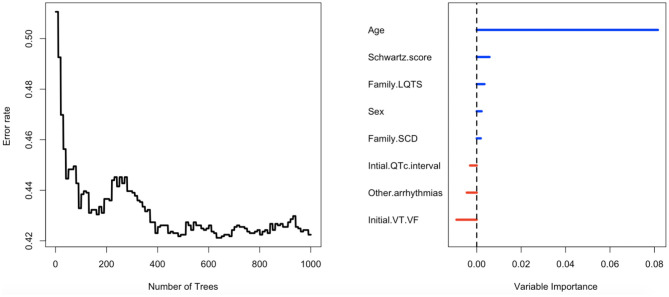
Optimal tree number selection (Left) and variable importance ranking for RSF model to predict VT/VF in LQTS (Right).